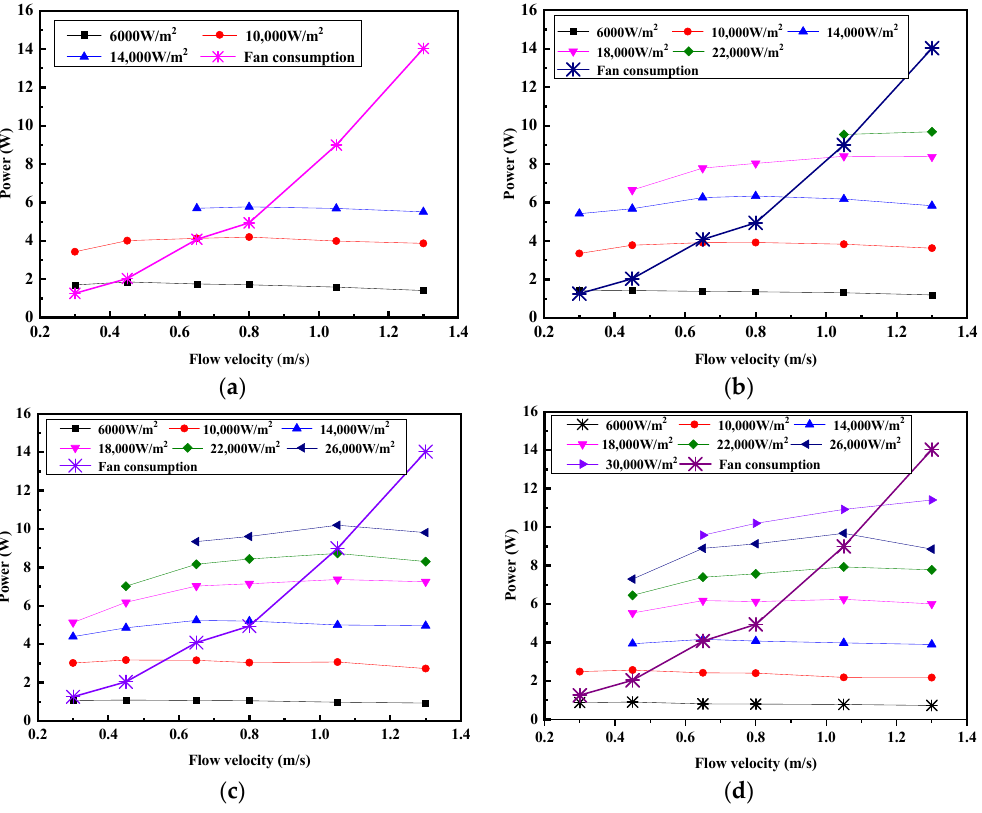
Figure 5. Temperature Profiles from hot plate to air ambient. (a) Aluminum hot plate and heat sink with fan cooling. (b) As in (a), but with a lower flow velocity. (c) As in (a), but with a lower heat flux.